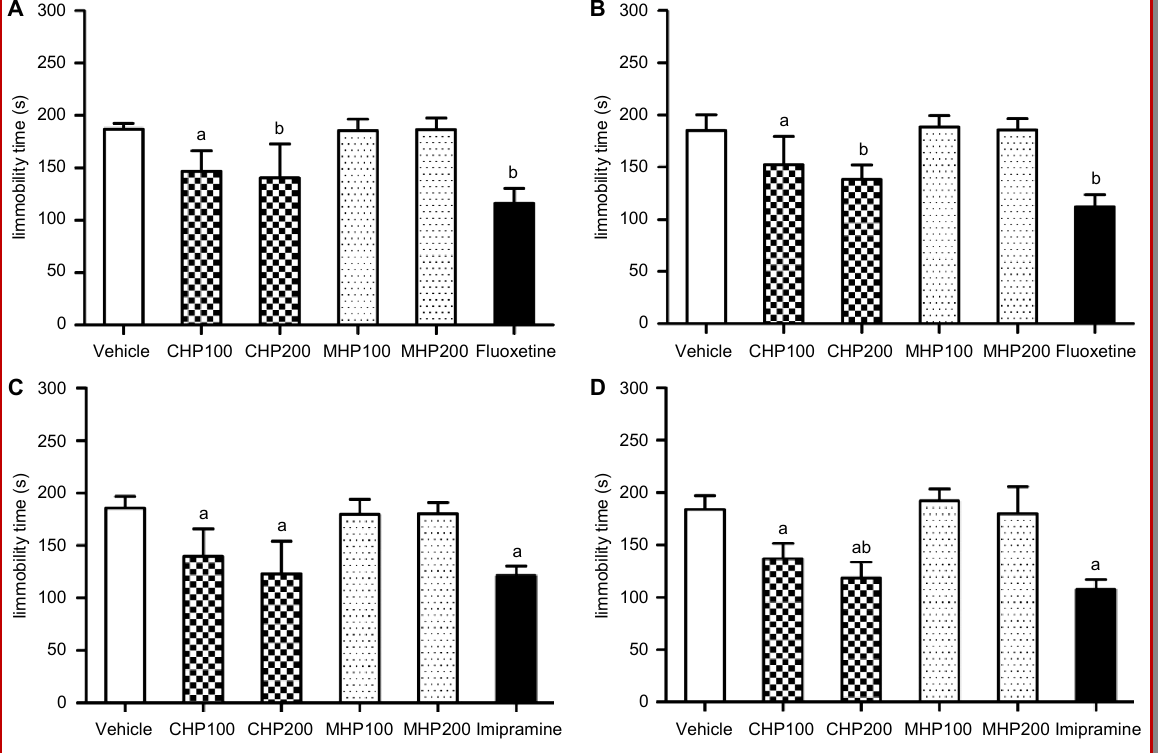
Figure 1: Effects of H. patens extracts (100 and 200 mg/kg), or standard (10 mg/kg) for 4 days (A,C) and 7 days (B,D) administra- tion on the immobility time in the forced swim test (A,B) and tail suspension test (C,D). The results are expressed as the mean ± SEM, n=6 in each group. a p<0.01, b p<0.001 VS the vehicle-treated control group. (CHP- Chloroform extract of H. patens , MHP- Methanol extract of H.